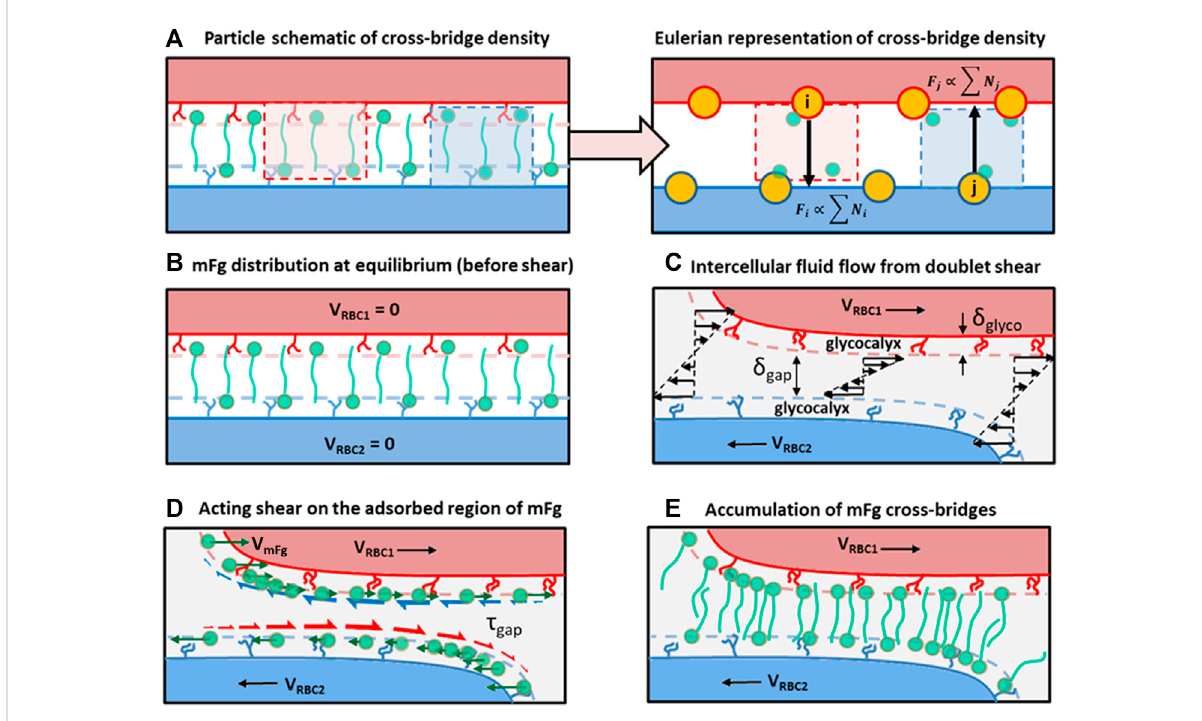
FIGURE 2 Schematics of the cross-bridge migration model (CBMM) and its conceptual development. (A) A particle to Eulerian depiction of the cross- bridge density represented at the adhesion vertices. (B) Homogenous distribution of cross-bridges at the adhesion interface at doublet formation equilibrium, which represents the initial condition in our doublet formation/disaggregation simulations. (C) Intercellular Couette fl ow that develops due to the applied displacement on RBCs in the doublet. (D) Shear stress acting on adsorbed regions of mFg causing relative velocity drift between mFgand theRBCsurfaceadsorbing mFg.Green arrows representthemFgvelocitythat deviates fromRBC velocity dueto friction. Red half arrows represent the frictional drag force acting on mFg adsorbed on RBC2 surface. Blue half arrows represent the frictional drag force acting on mFgadsorbedonRBC1 surface. (E) Theresultingcross-bridgeaccumulationintheintercellularadhesion regionfromweakassociationbetweenthe non-adsorbed mFg tails and pairing RBC